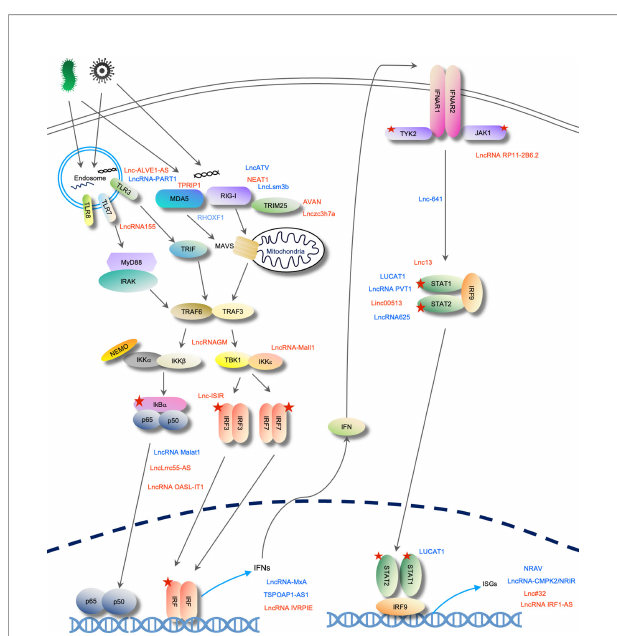
FIGURE 7 | A summary of lncRNAs discussed in this review. From IFN signaling activation to ISG transcription, discussed lncRNAs are positioned at sites of action. Five-sided star represents phosphorylation modi fi cation. LncRNA in blue represents negative regulators; lncRNA in red is positive regulators for IFN